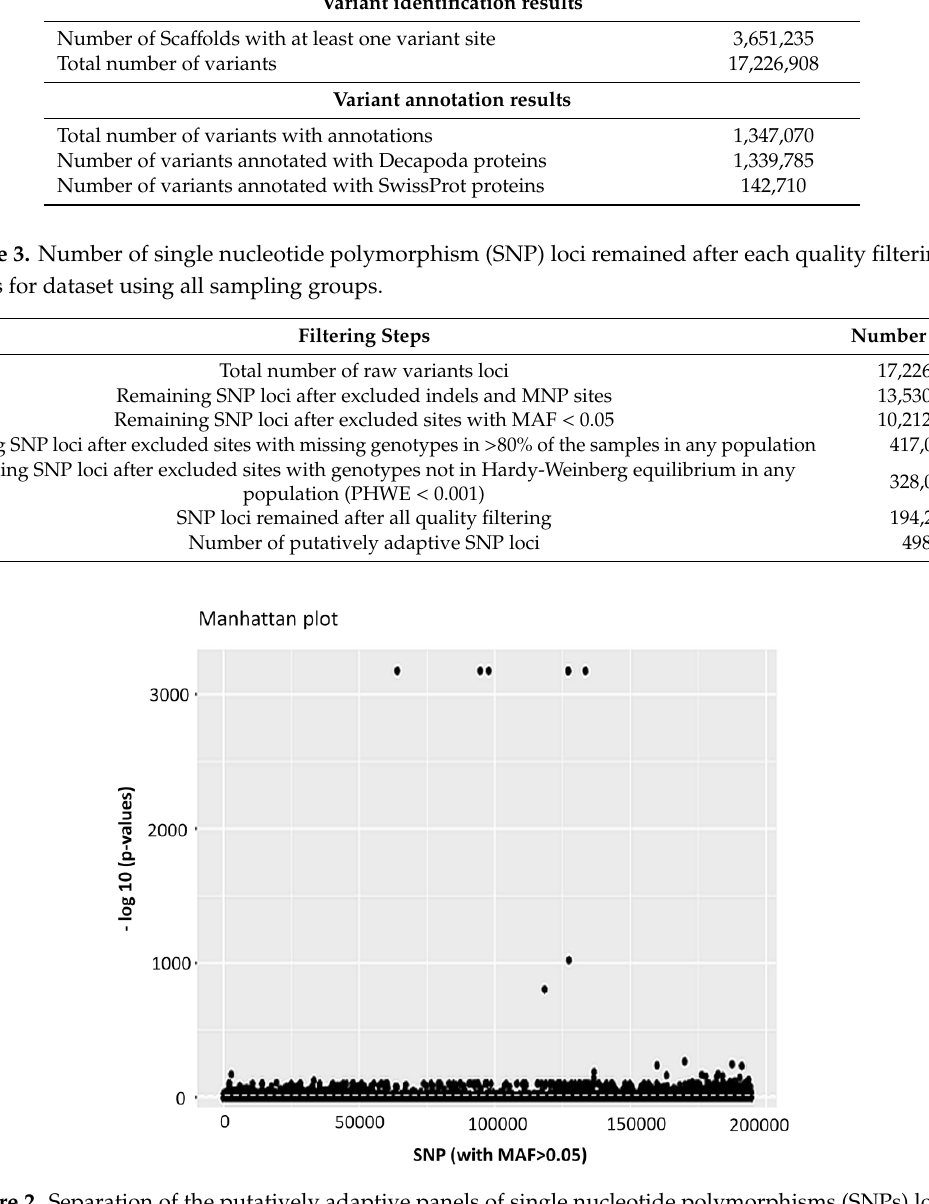
Figure 2. Separation of the putatively adaptive panels of single nucleotide polymorphisms (SNPs) loci, based on the pcadapt approaches. Among the 194,259 SNP loci, the pcadapt approach detected 4983 SNPs, as putative adaptive loci (above the dotted